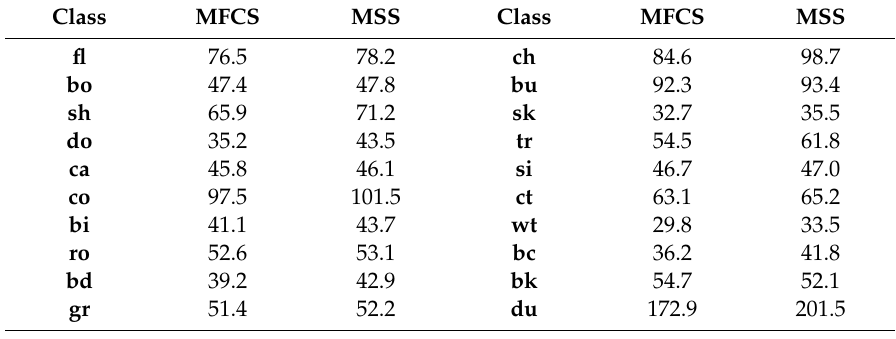
Table 2. Comparison of Computation Time of Objects Segmentation Algorithms over MSRC Dataset.